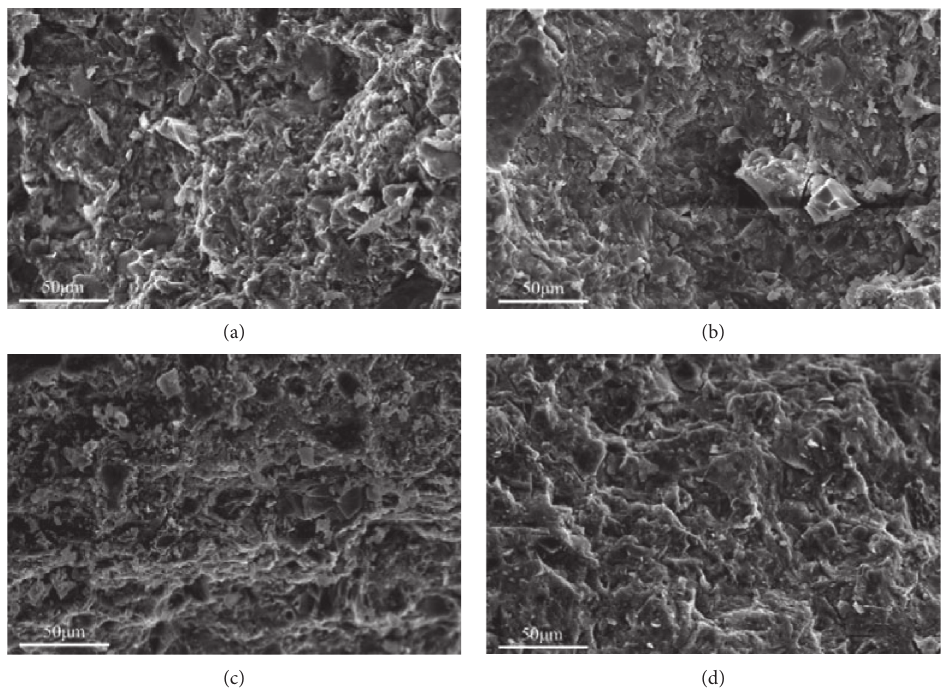
Figure 10: The SEM images of the HCS samples: (a) N0 at a curing period of 3 days; (b) NB3 at a curing period of 3 days; (c) N0 at a curing period of 28 days; (d) NB3 at a curing period of 28